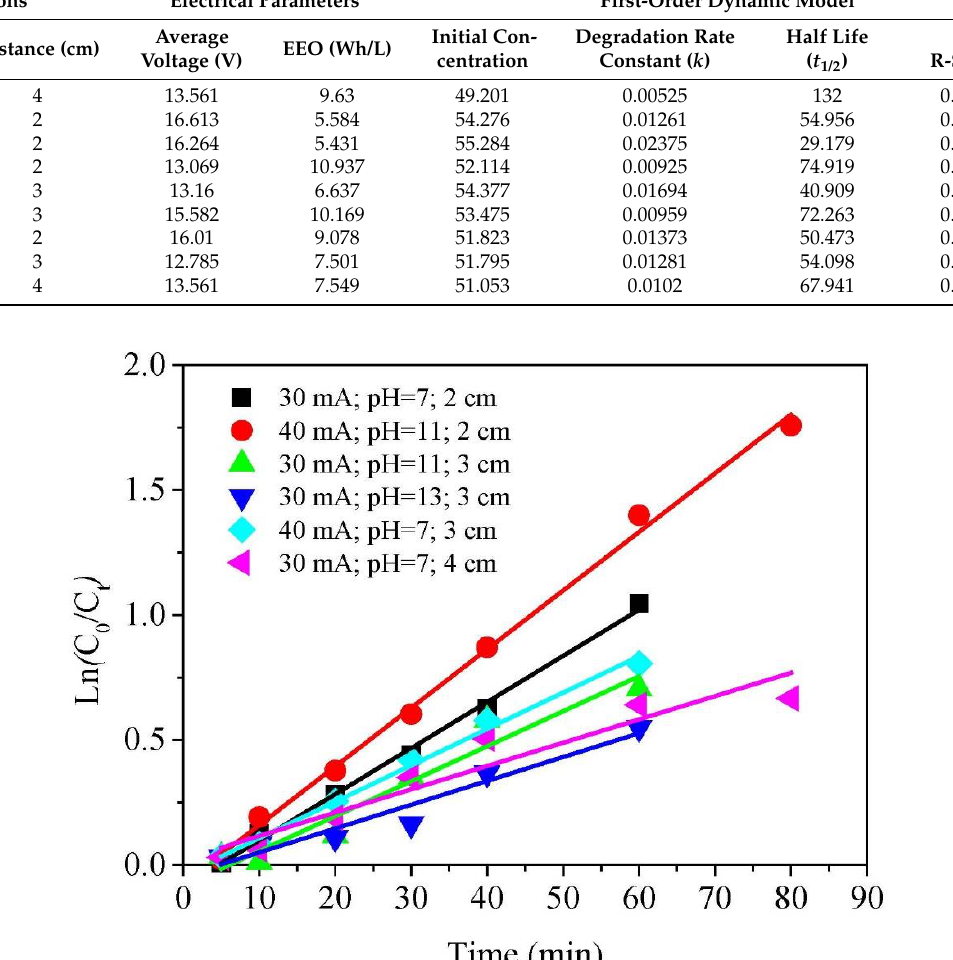
Table 1. The pseudo-first-order kinetic simulation parameters of norfloxacin electrochemical deg- radation with PbO 2 -NF electrode under different operating conditions.